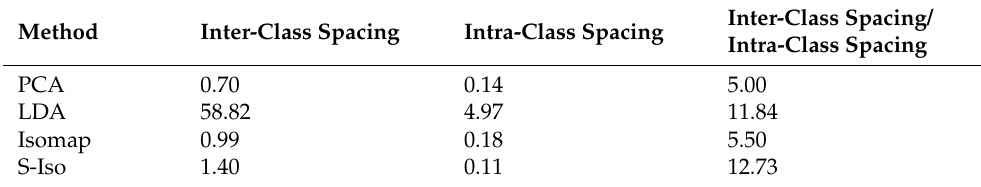
Table 5. Performance comparison between four methods.